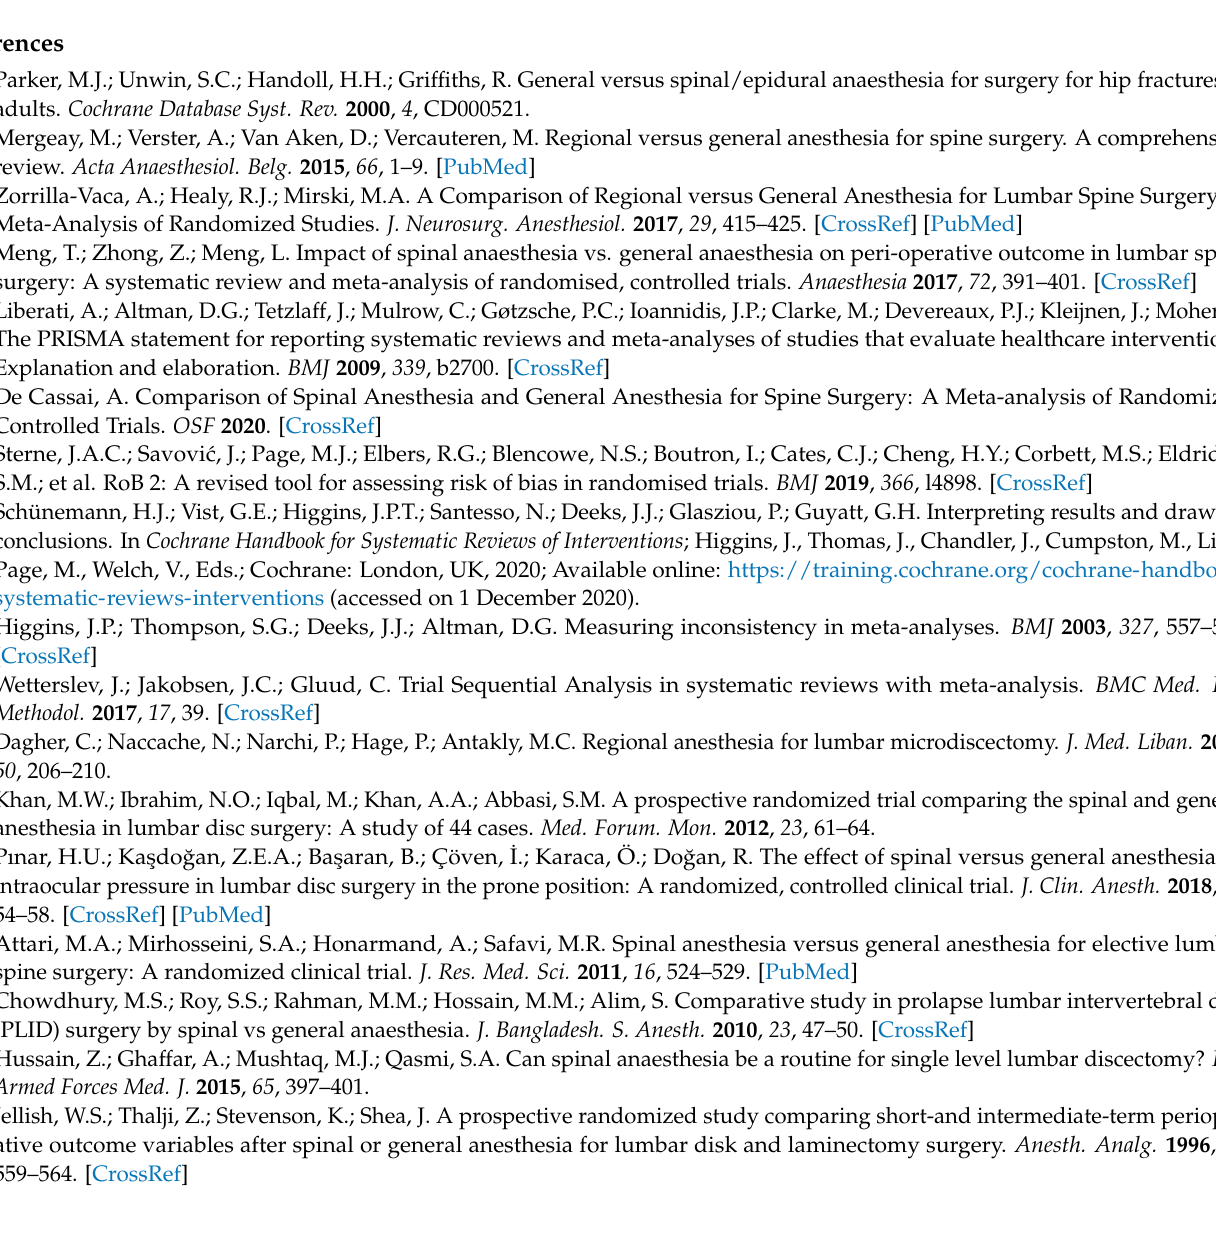
Figure S3: Funnel plots, Table S1: Search strategy, Table S2: Group comparison, Table S3: Bias assessment based on Attari (2011), Table S4: Summary of findings